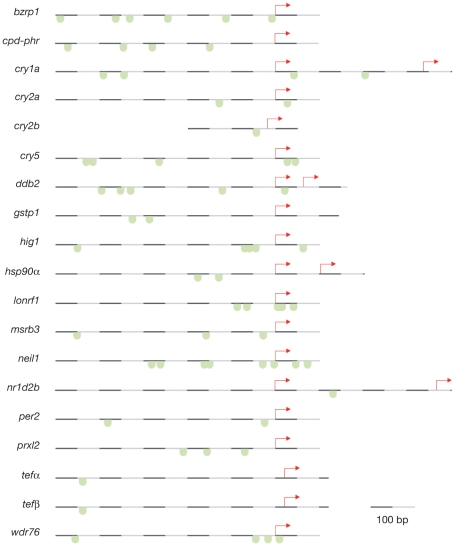
All promoters of the light-induced genes contain PAR elements.Genomatix software was used to predict PAR response elements in a 500 bp region upstream of the start codon in the promoters of all light-induced genes. Since the untranslated region of cry2b is not present in the Genomatix database this gene was analysed separately. Start codons are indicated with red arrows, and the locations of predicted PAR elements are marked with green boxes.